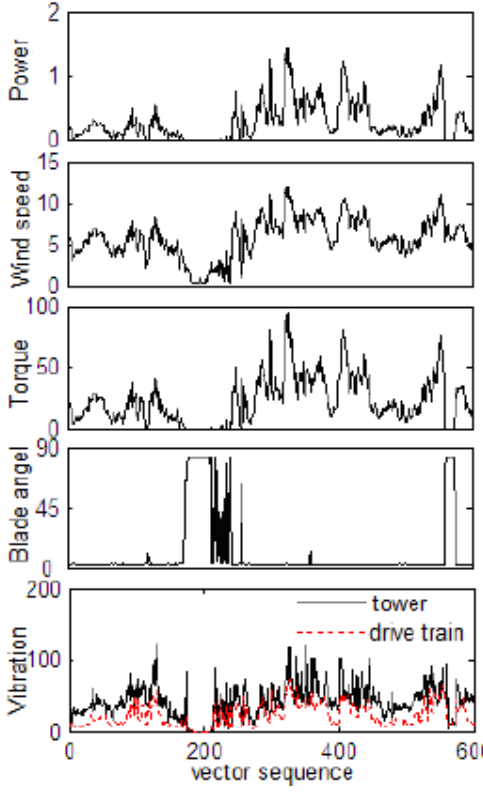
Figure 1. Trends for tower vibration and related variables with below rated wind speed.